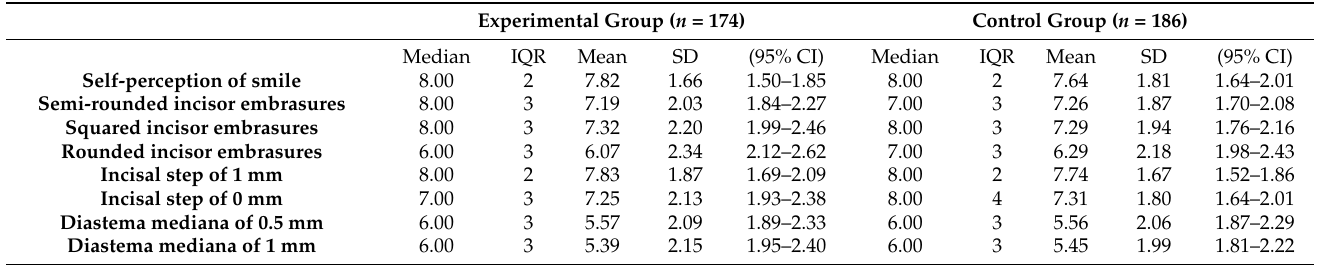
Table 2. Mean scores, standard deviations, medians, and confidence intervals for each individual anomaly in the experimental and control group, in the first testing.